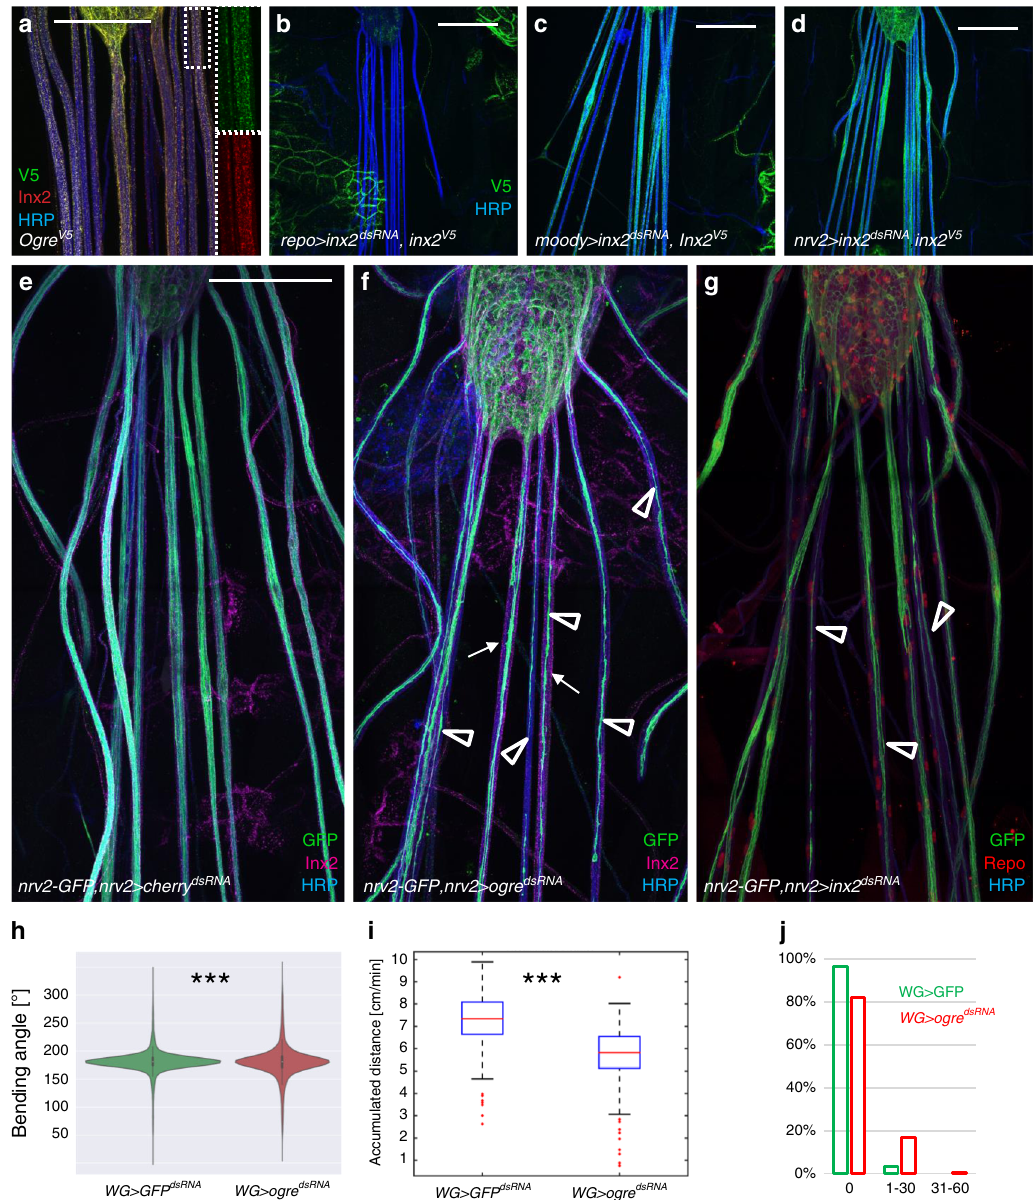
Fig. 4 Wrapping glial cells require innexins for their growth. Third instar larval fi let preparations expressing endogenously V5-tagged Ogre ( a green), or endogenously V5-tagged Innexin2 ( b – d green), or carrying a nrv2-GFP fusion ( e – g , green). HRP (blue) labels neuronal membranes, ( a , e – g ) Innexin2 antibody staining is shown in red. More than ten animals were analyzed for each genotype. Representative images are shown. Scale bars are 200 µ m. a In a control larva, Innexin1 (Ogre, green) and Innexin2 (Inx2, red) show overlapping localization. The boxed area is shown in higher magni fi cation. b Upon panglial, RNAi mediated suppression of innexin2 expression no Inx2 can be detected in nerves. c Upon suppression of innexin2 expression only in the subperineurial glial cells some reduction in Inx2 can be observed. d Similar expression patterns are observed upon innexin2 suppression in wrapping glia. e Note that wrapping glial cells cover the entire width of the nerve. f Upon knockdown of ogre in wrapping glia, the differentiation of wrapping glia is affected (arrowheads). Mainly thin wrapping glial processes can be detected. Inx2 is seen in the peripheral nerves (arrows). g A similar phenotype is noted when innexin2 is suppressed in the wrapping glia (arrowheads). h Bending distribution of control [ nrv2-Gal4; 90C03-Gal80/UAS-GFP dsRNA ] and ogre knockdown third instar larvae [ nrv2-Gal4; 90C03-Gal80/UAS-ogre dsRNA ]. ogre knockdown larvae show increased bending ( p = 1.36E − 25, t test). i The accumulated distance per minute is slightly reduced in ogre knockdown animals ( p = 1.6E − 19, Wilcoxon rank-sum test, n = 88 control larvae and n = 69 larvae expressing ogre dsRNA ). Box plot shows median (red line), boxes represent the fi rst and third quartile, whiskers show standard deviation, red points show outliers. j Same dataset as in ( i ). Quanti fi cation of the coiling phenotype. The relative distribution of 300 frames long movement clips (n = 259 30 s long video clips with 300 frames each) with 0, 1 – 30, or 31 – 60 frames showing coiling. Green denotes control, red denotes larvae expressing ogre dsRNA in wrapping glia. Genotypes as in ( h